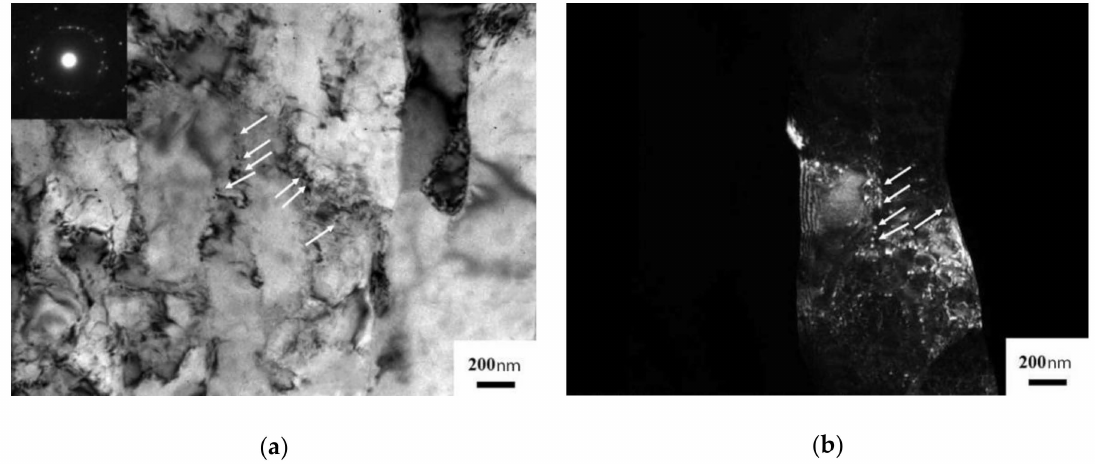
Figure 5. Structure of the sample after ECAP with wire forming: ( a ) the longitudinal section (TEM, light-field image, and arrows show secondary phase precipitates) and ( b ) the cross-section (TEM, dark-field image, and arrows show secondary phase